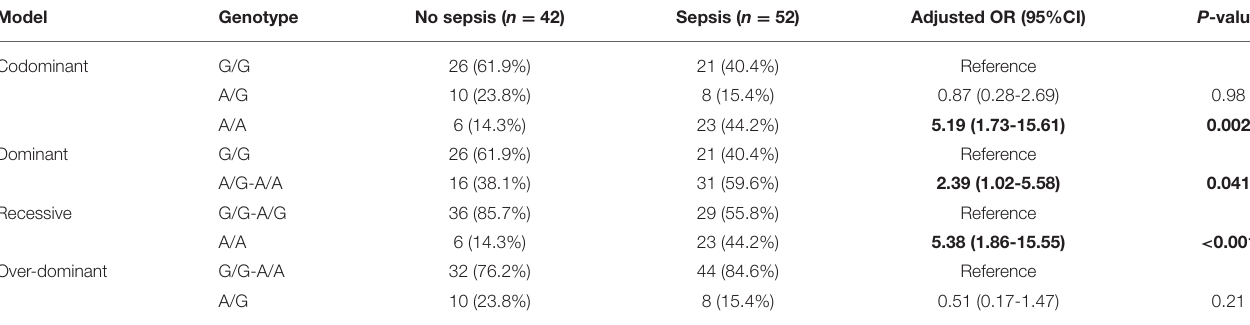
TABLE 5 | Genetic association models for risk of developing sepsis in neonatal lung disease